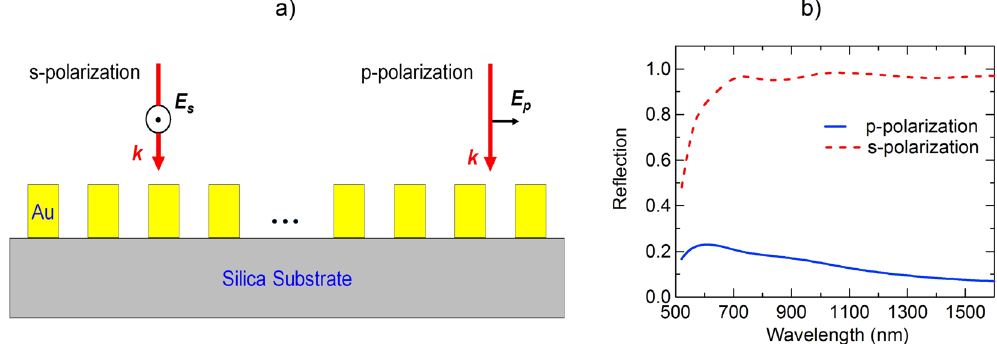
Figure 2. Plasmonics grating. ( a ) Gold grating on silica substrate. ( b ) Corresponding reflection for p-and s-polarized light under normal incidence.